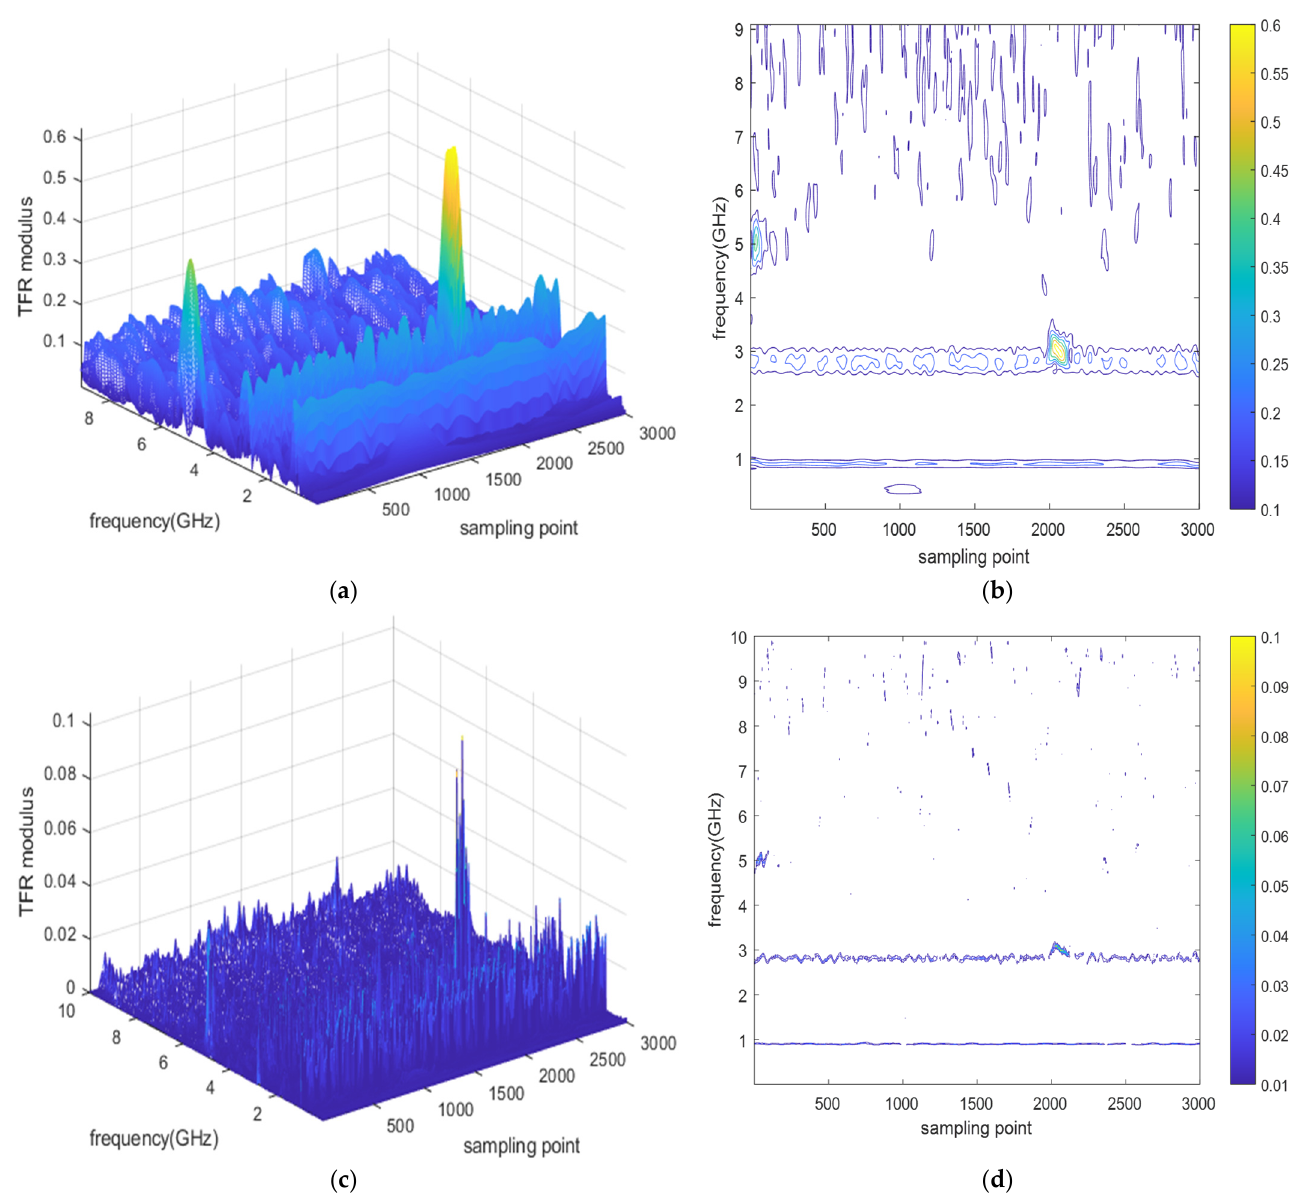
Figure 10. CWT TFR and the reassigned TFR. ( a ) CWT TFR, ( b ) contour of CWT TFR, ( c ) reassigned TFR, ( d ) contour of reassigned TFR.